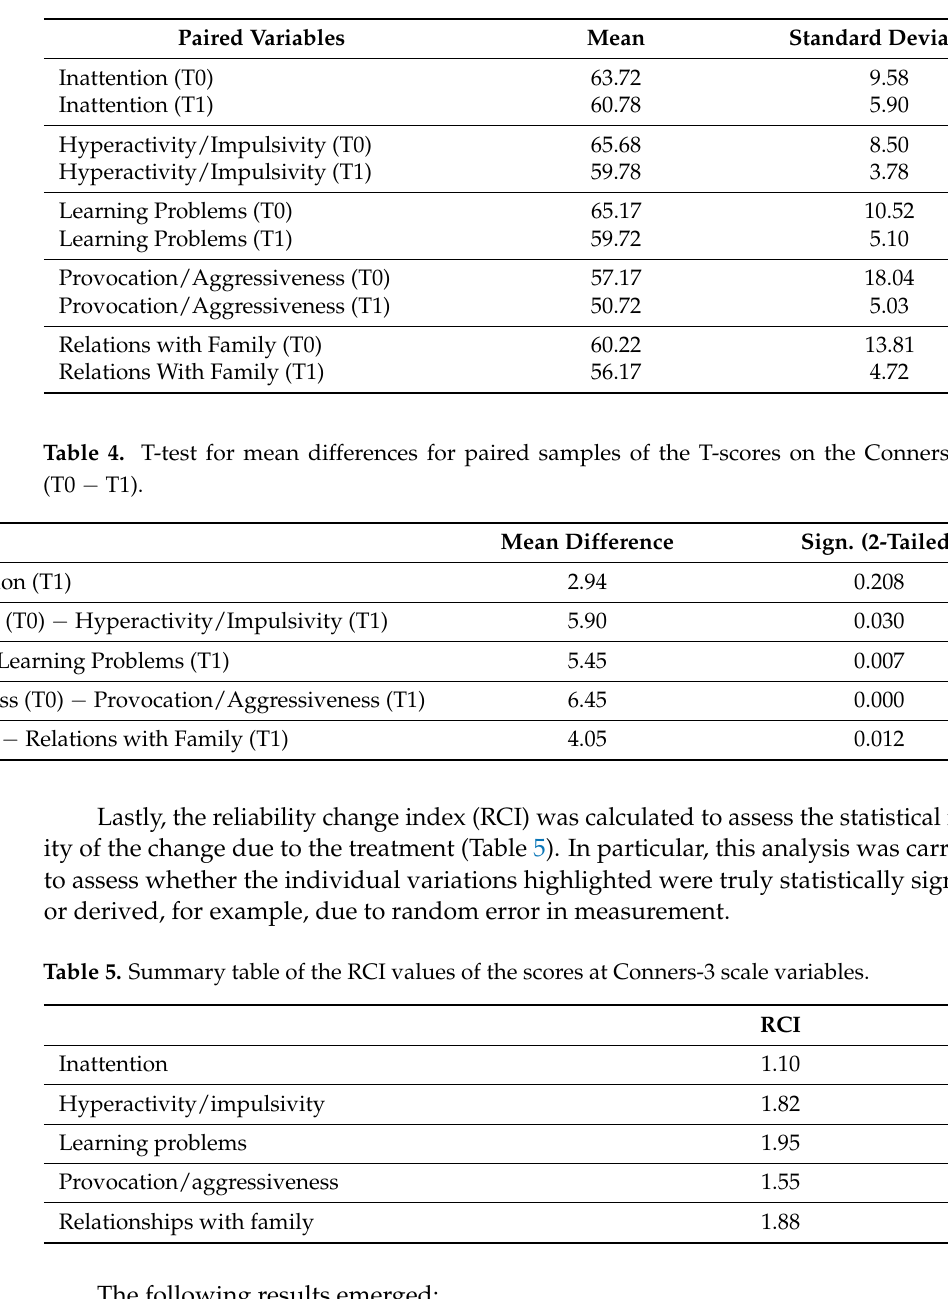
Table 3. Descriptive analysis of the averages of the T-scores obtained for the Conners-3 scale variables at T0 and T1.